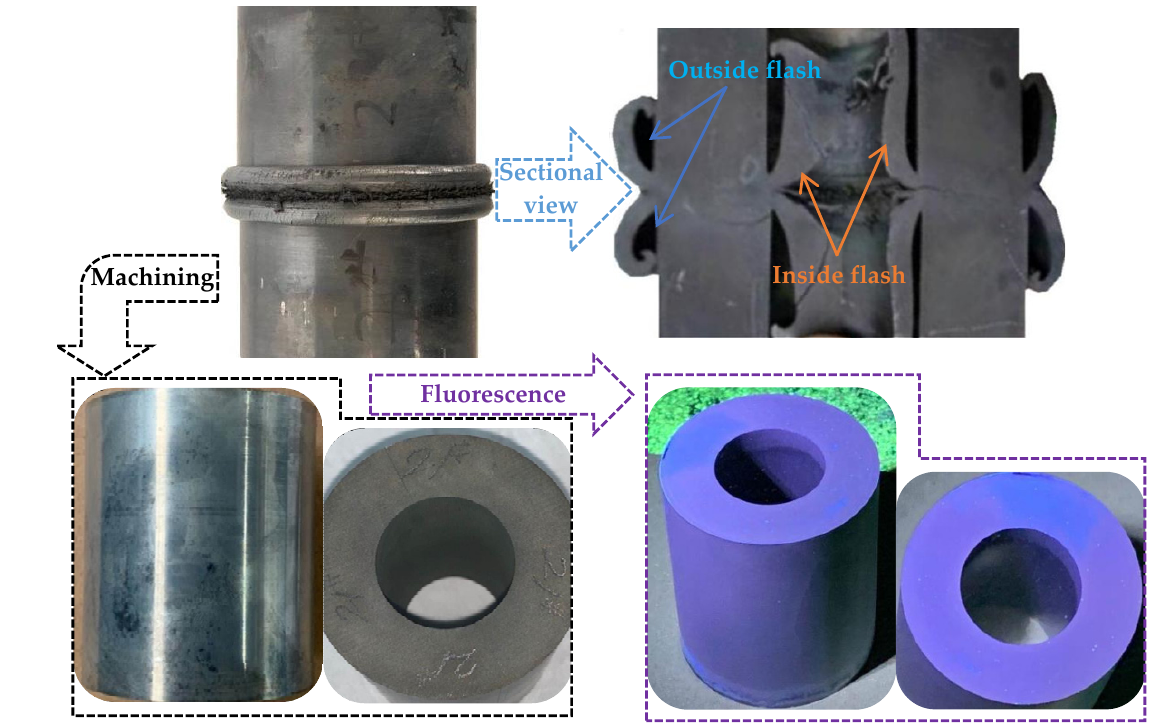
Figure 1. Sample diagram of solid solution GH4065A alloy IFW joints.